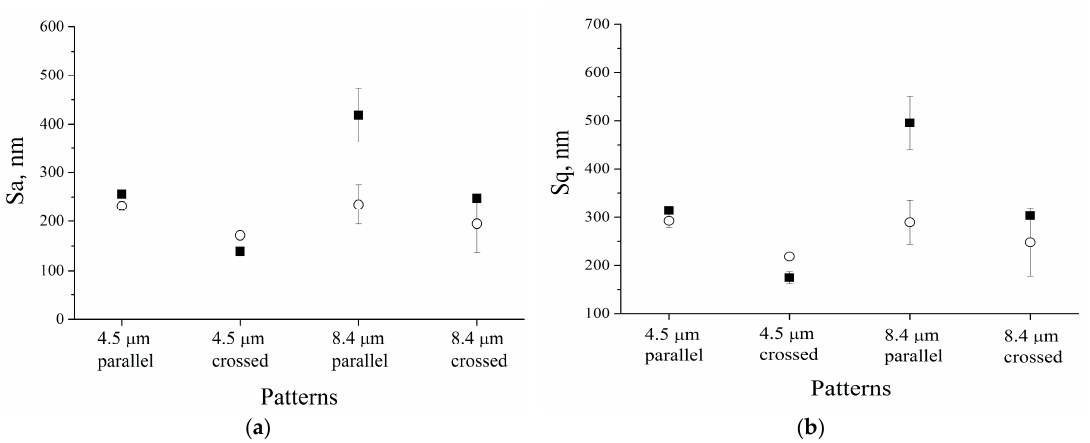
Figure 1. The roughness parameters of different Ti surface patterns with a 35 × 35 μm (cid:2870) scan area: ■ —without hydroxyapatite (HA) film, and ○ —with HA film. ( a ) S a roughness parameter; ( b ) S q roughness parameter